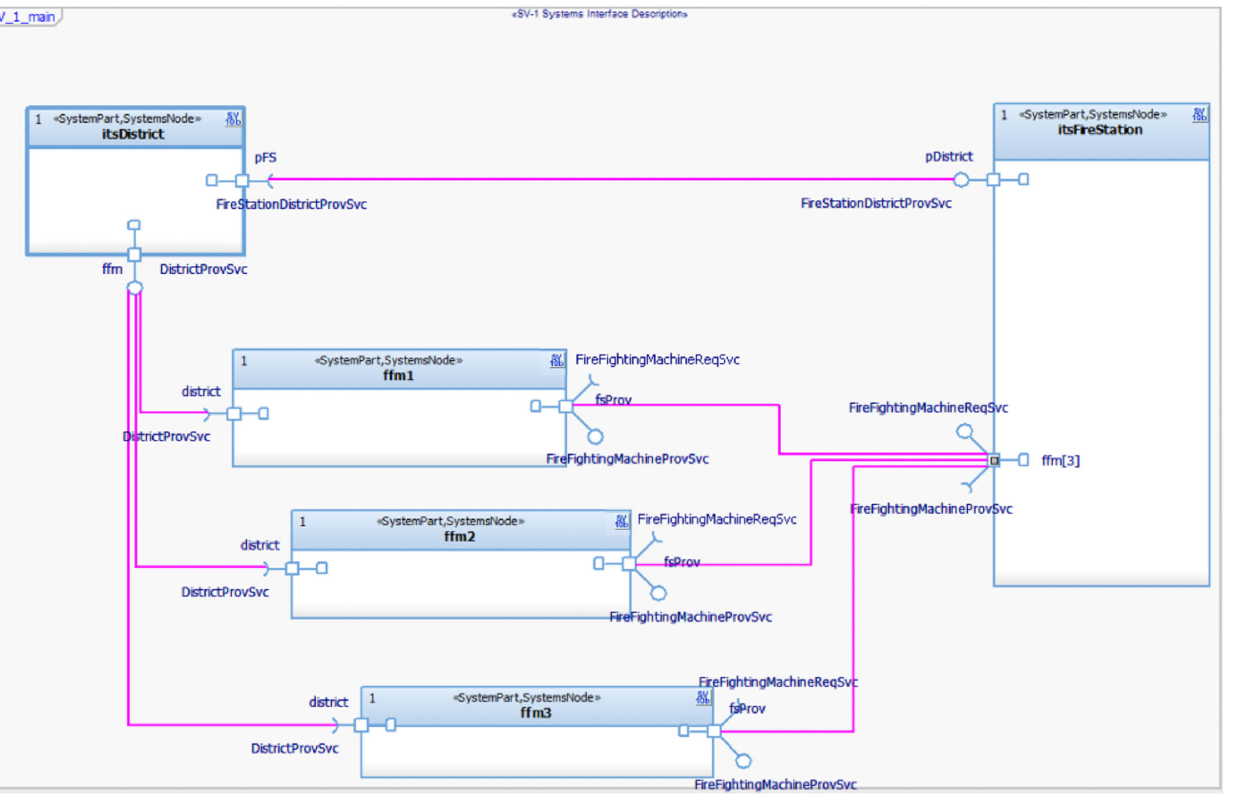
Figure 4. CAE ‐ ATG top ‐ level SV ‐ 1 system interface description diagram. Figure 4. CAE-ATG top-level SV-1 system interface description